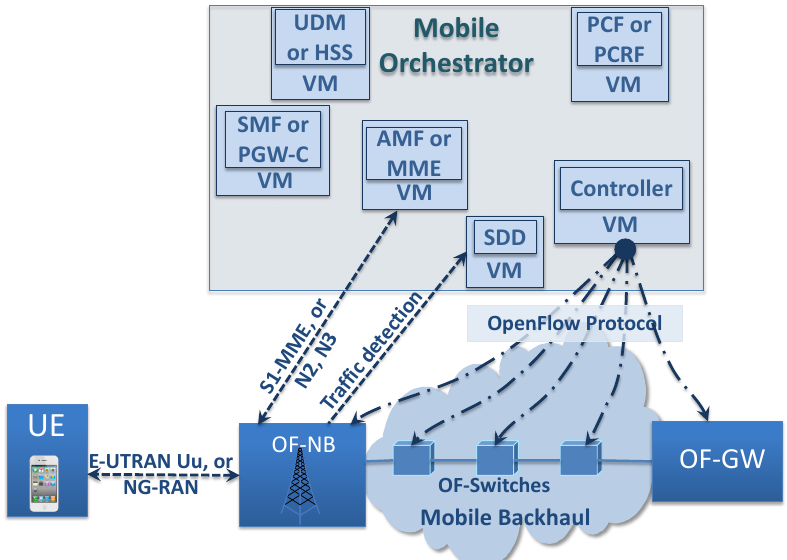
Figure 1. Architectural proposal, visualizing the 4G and 5G mobile control entities. UDM, Unified